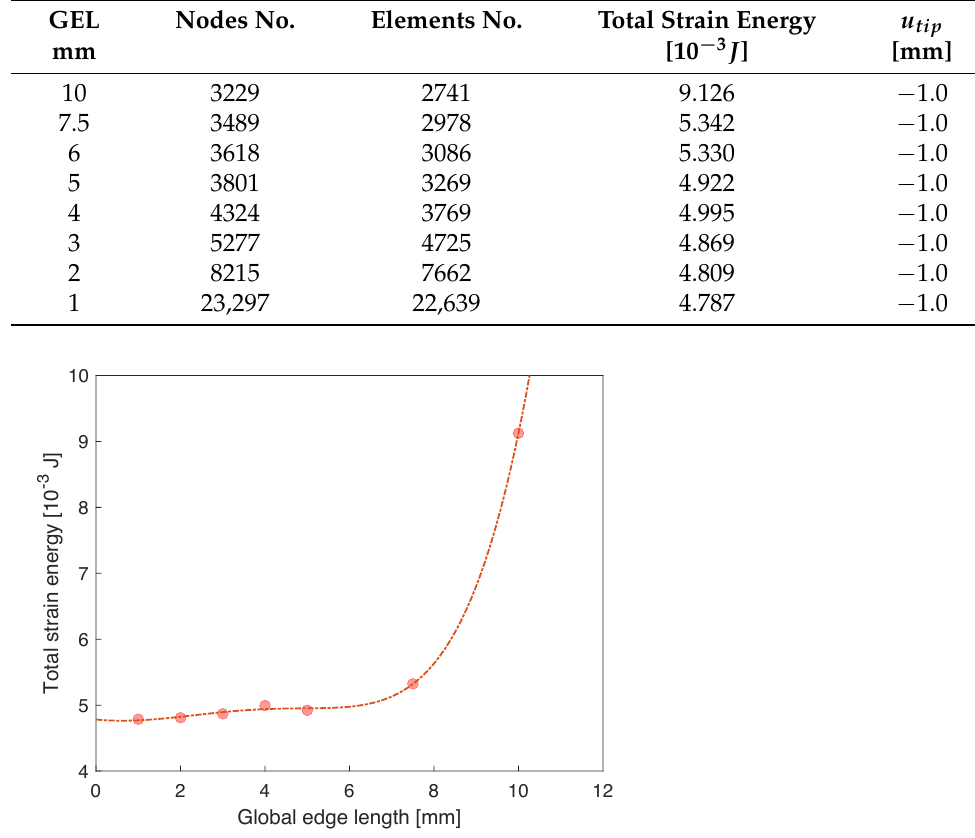
Figure 13. FE model, model setup: convergence analysis of the total strain energy vs. the global edge length.